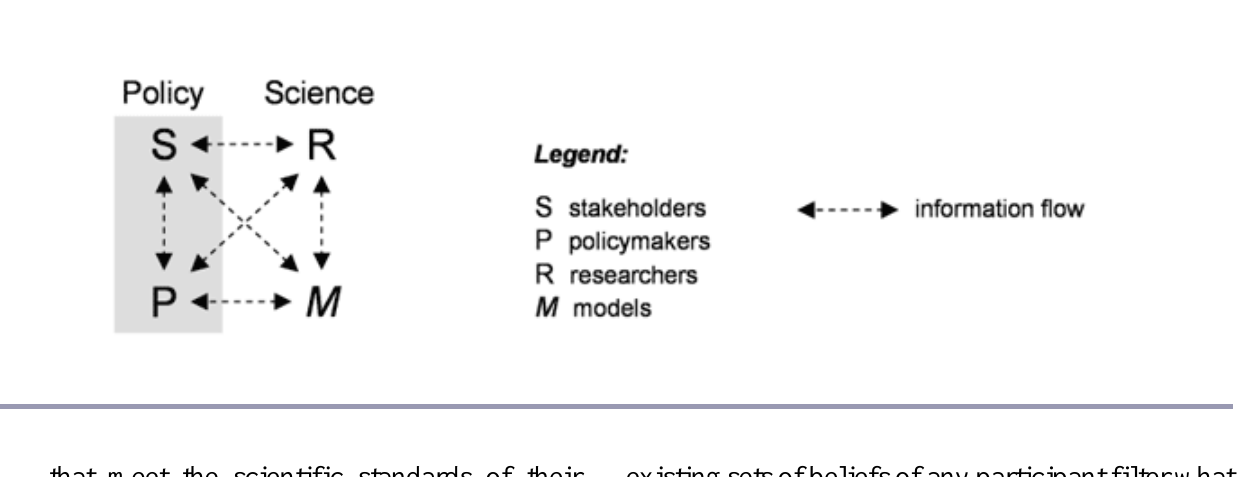
Fig. 2. A representation of flows at the policy–science